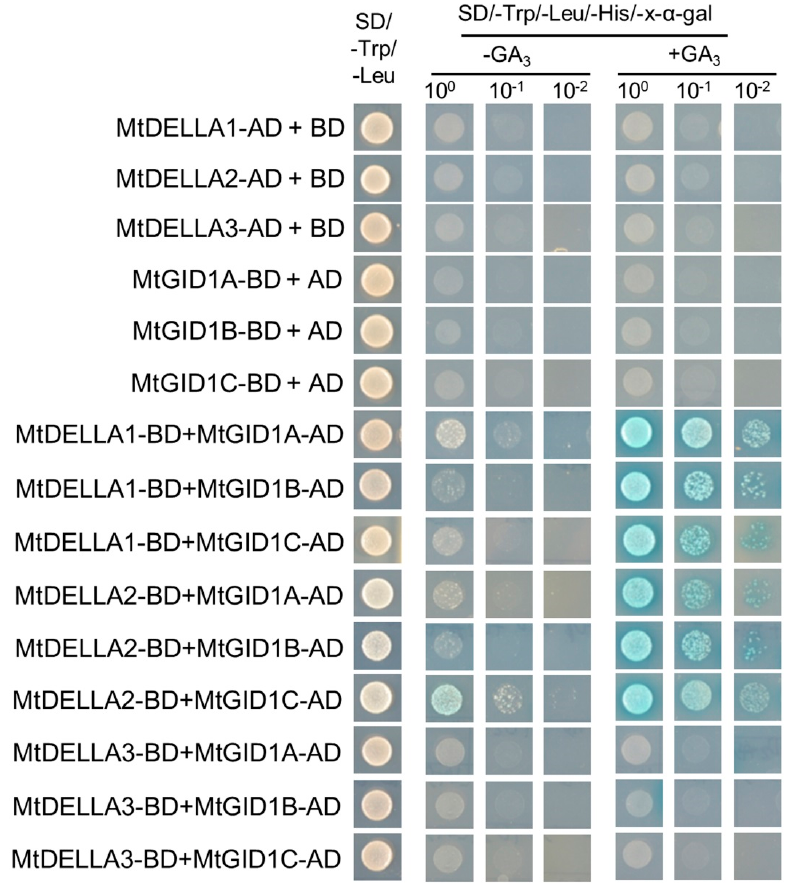
Figure 6. Multiple Sequence alignment of DELLA, VHYNP and SIM domains in DELLA and GID1 proteins. ( A ) DELLA and VHYNP domain sequences alignment for DELLA homologues in A. thaliana and M. truncatula . Black lines indicate the DELLA (left) and VHYNP (right) domain. ( B ) SUMO-Interaction Motif (SIM) sequences alignment for GID1 homologues in A. thaliana and M. truncatula . The black line indicates the SIM motif (W[V / I]LI). Amino acids that are conserved throughout are shaded in different colors.